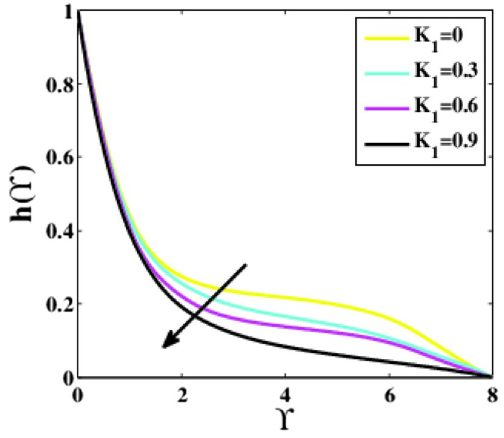
Figure 6. Plots of h (ϒ) for K 1 .